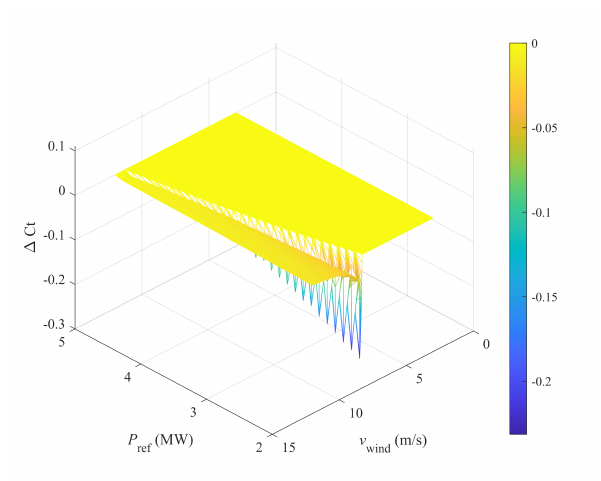
Figure 9. ∆ ω between different derating strategies.